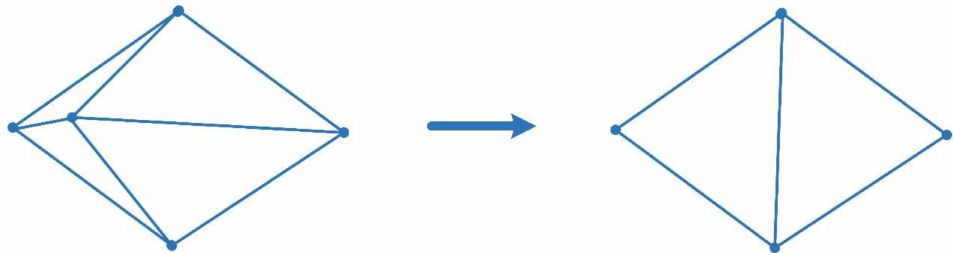
Figure 3. The deletion of points reduces the number of narrow